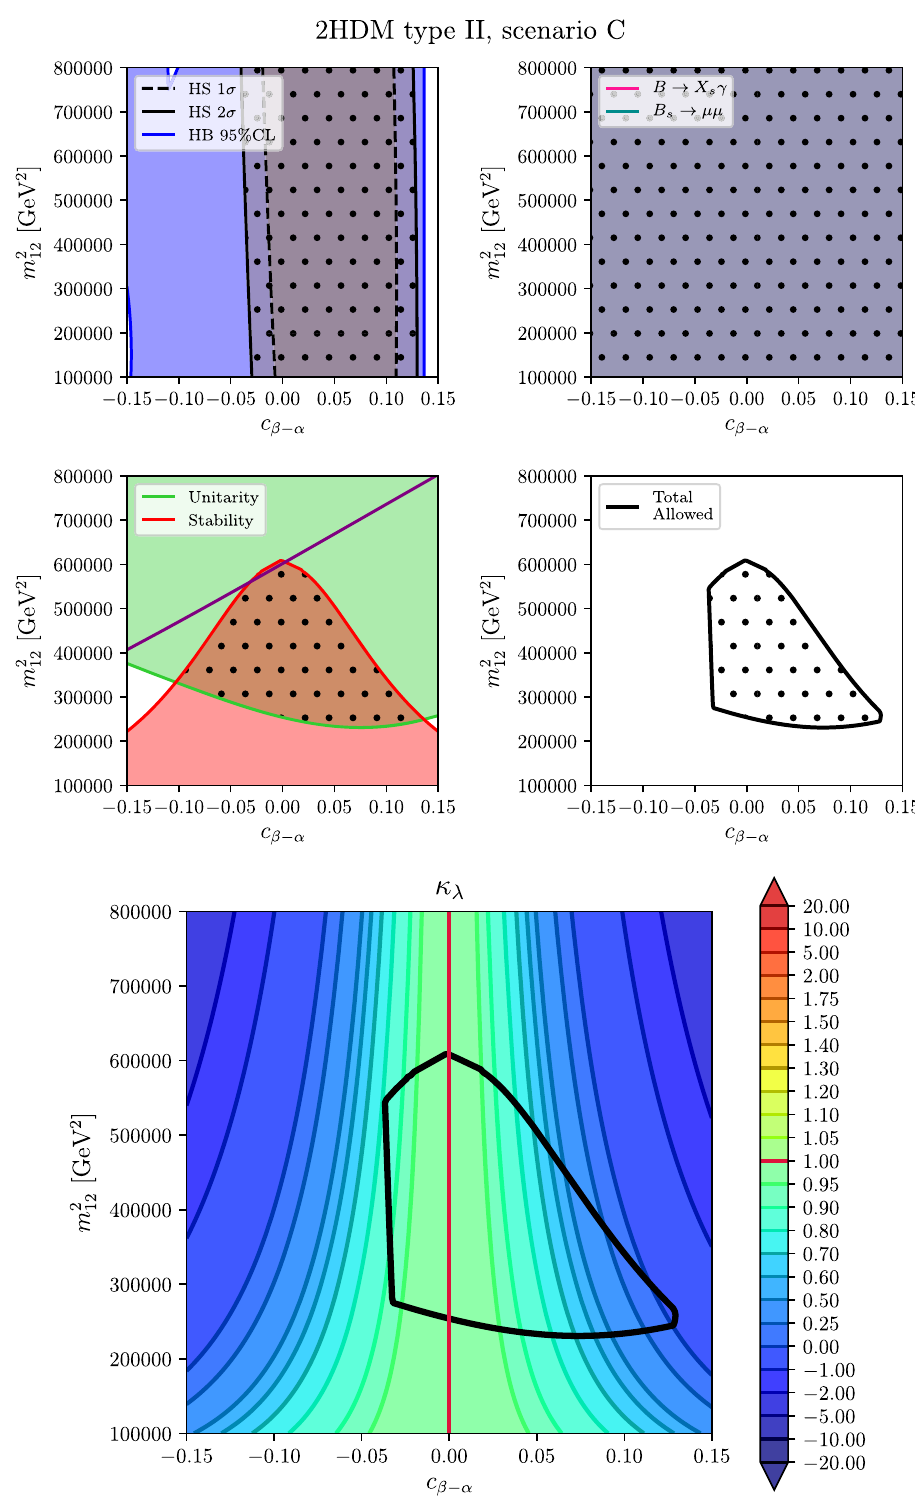
Fig. 14 Predictions for κ λ = λ hhh /λ SM in the 2HDM type II, scenario C, in the ( c β − α , m 2 m H ± = 1100 GeV and tan β = 0 . 9. The description of the